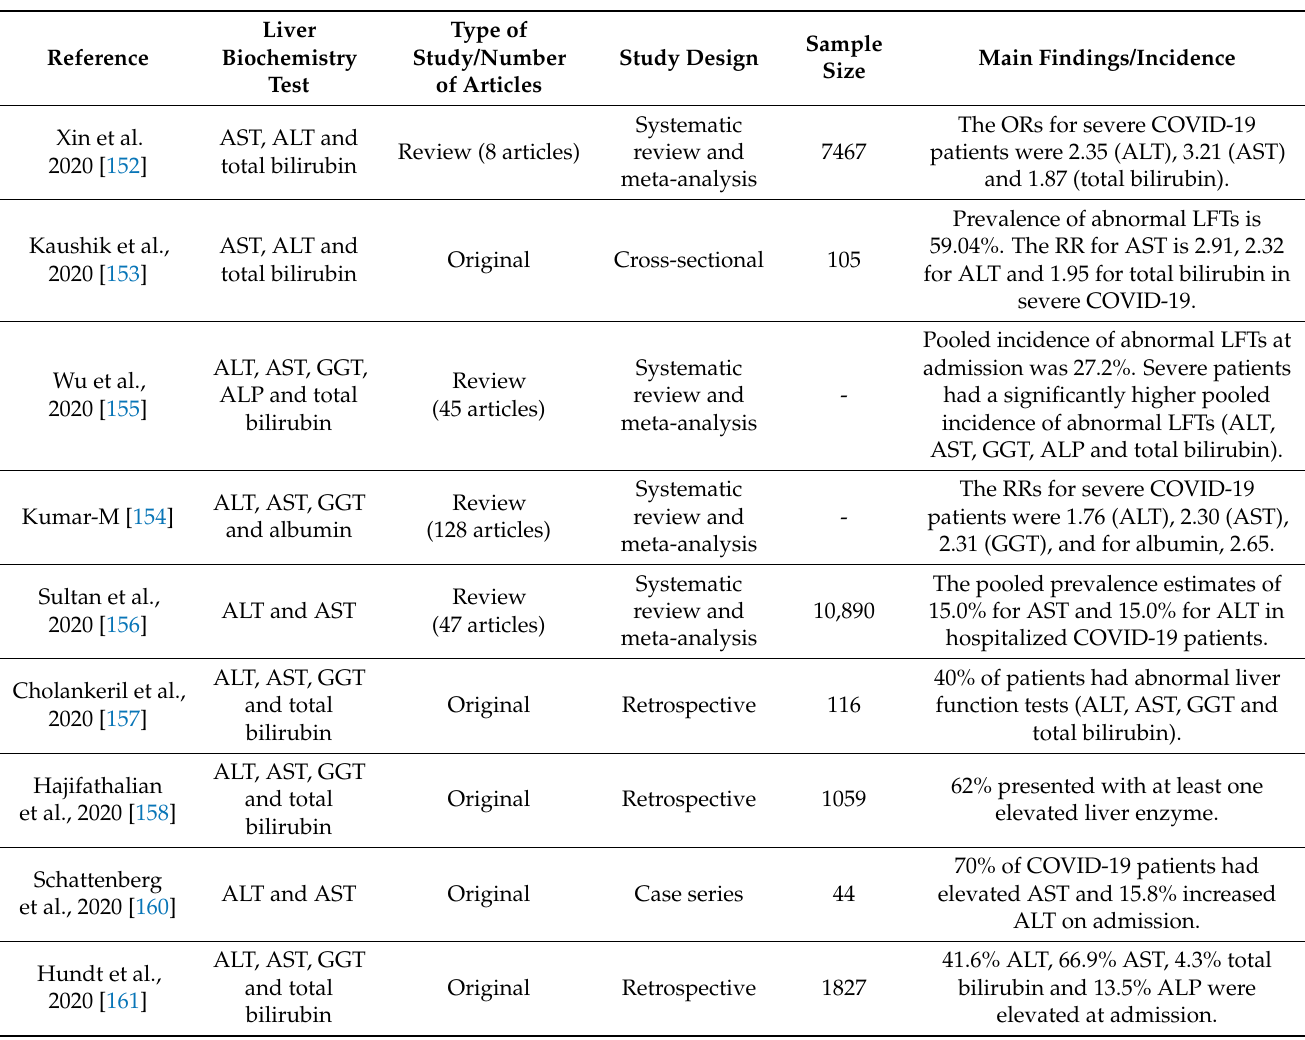
Table 1. Abnormal liver biochemistry tests in COVID-19 patients with severe